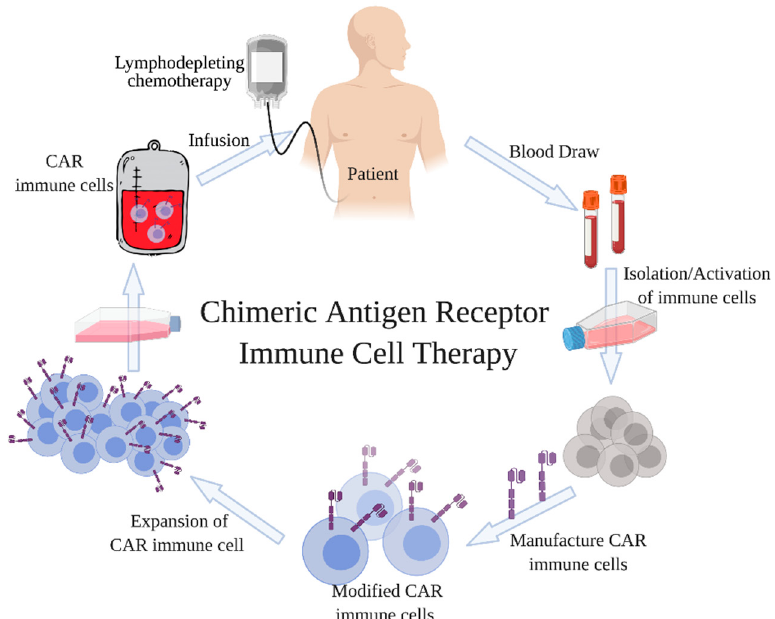
Figure 1. Treatment of patients with CAR immune cells. In the first step, immune cells are isolated from the patient’s blood by leukapheresis. These autologous immune cells are then manufactured off-site and genetically modified to target and kill antigen carrying cancer cells. The treatment is initiated by intravenous infusion of CAR immune cells into the patient.